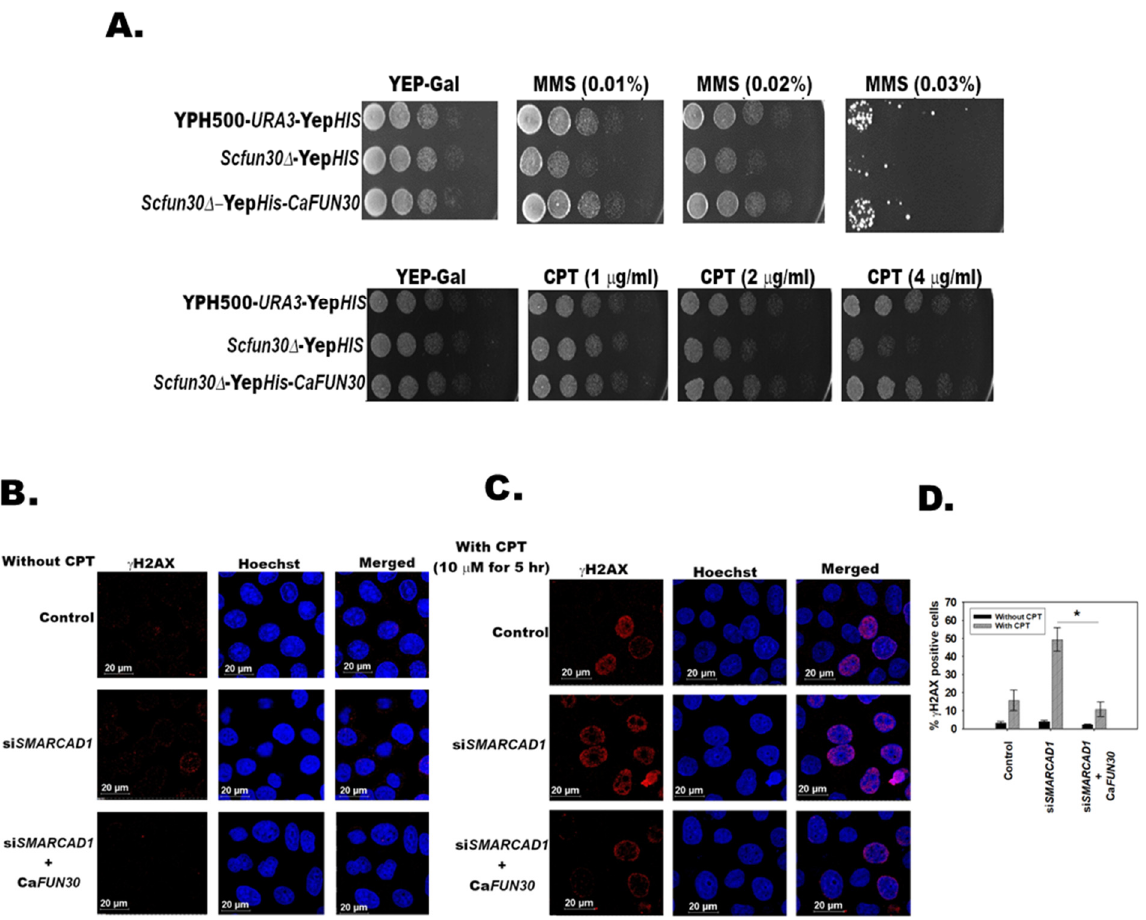
Figure 1 . C. albicans Fun30 is a functional homolog of both S. cerevisiae Fun30 and human SMARCAD1. ( A ). Sensitivity to MMS and CPT of wild type YPH500 URA3 containing Yep HIS (YPH500- URA3 -Yep HIS ), Scfun30 ∆ - Yep HIS , and Scfun30 ∆ overexpressing C. albicans FUN30 ( Scfun30 ∆ - Yep HIS-CaFUN30 ) was studied using plate (spot) assays. ( B ). γ H2AX foci was monitored using confocal microscopy in HeLa cells without CPT treatment. ( C ). γ H2AX foci was monitored using confocal microscopy in HeLa cells after treatment with 10 µM CPT for 5 h. ( D ). Quantitation of γ H2AX positive cells. Control indicates HeLa cells transfected with control scrambled siRNA. The data is presented as an average ± s.d. of two independent experiments where at least 100 cells were counted in each experiment. * p < 0.05. In panels B and C, Red is γ H2AX and Blue is DNA stained with Hoechst